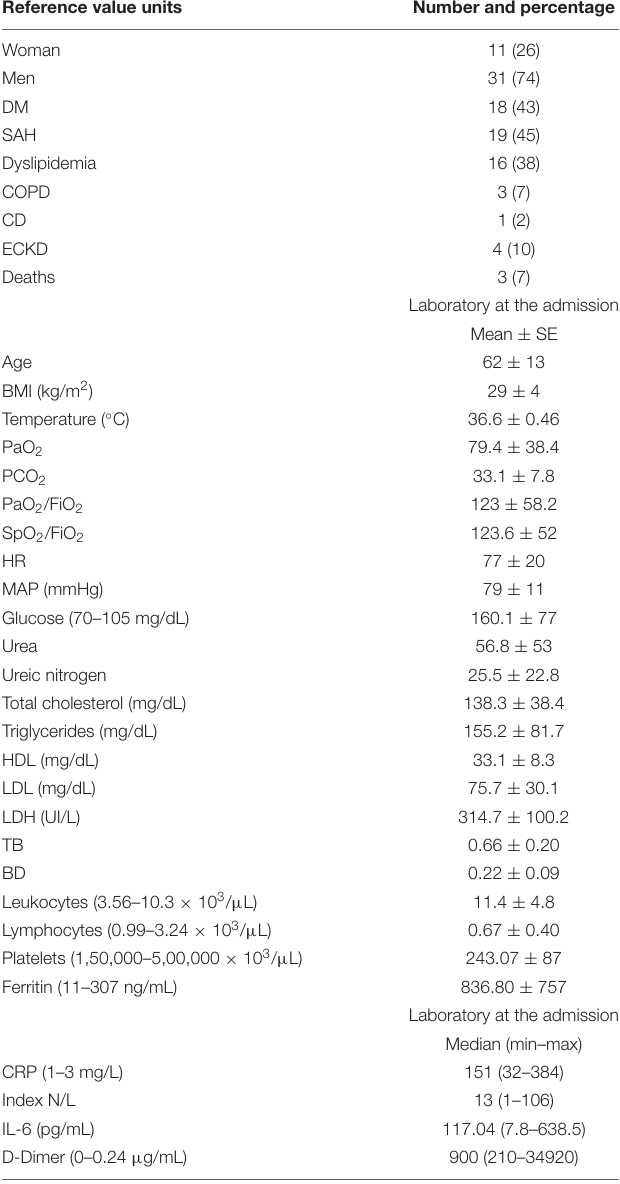
PaO 2 = arterial blood oxygen pressure, BMI = body mass index, HR = heart rate, MAP = mean arterial pressure, HDL = high-density lipoproteins, LDL = low- density lipoproteins, LDH = lactic dehydrogenase, TB = total bilirubin, DB = direct bilirubin, IL = interleukin, N/L = neutrophil/lymphocyte, DM = diabetes mellitus, SAH = systemic arterial hypertension, CD = cardiovascular disease, COPD = chronic obstructive pulmonary disease, ECKD = end-stage chronic kidney disease, CRP = C-reactive protein, FiO 2 = inspired fraction of oxygen, PCO 2 = partial pressure of carbon dioxide, SpO 2 = oxygen saturation.